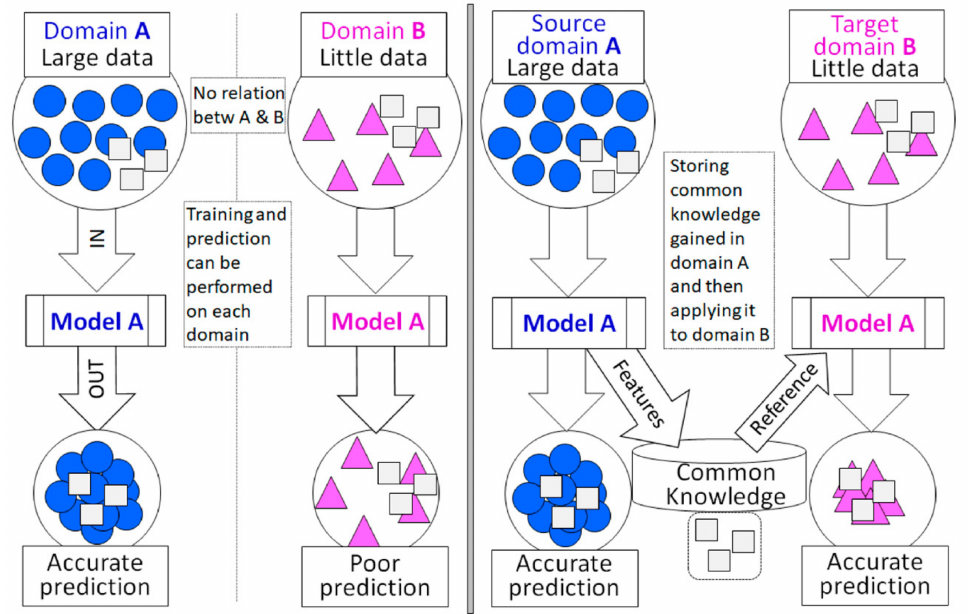
Figure 4. Simple overviews that show the model predictions with transfer learning ( right ) or without ( left ) transfer learning in Domains A and Domain B. The transfer learning extracts the features as common knowledge from Domain A and then applies common knowledge to predict in model B.